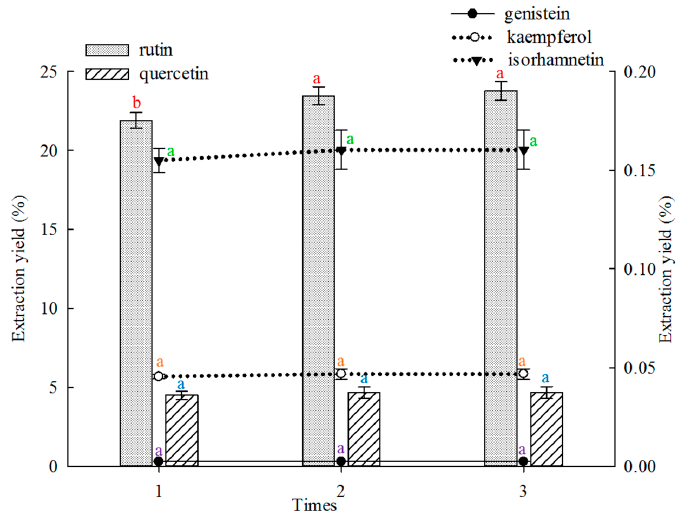
Figure 3. Effects of times on extraction yields of the five constituents (the bar and lines graphs are referenced to the left and right axes, respectively; different letters stand for significant difference at 5% level).